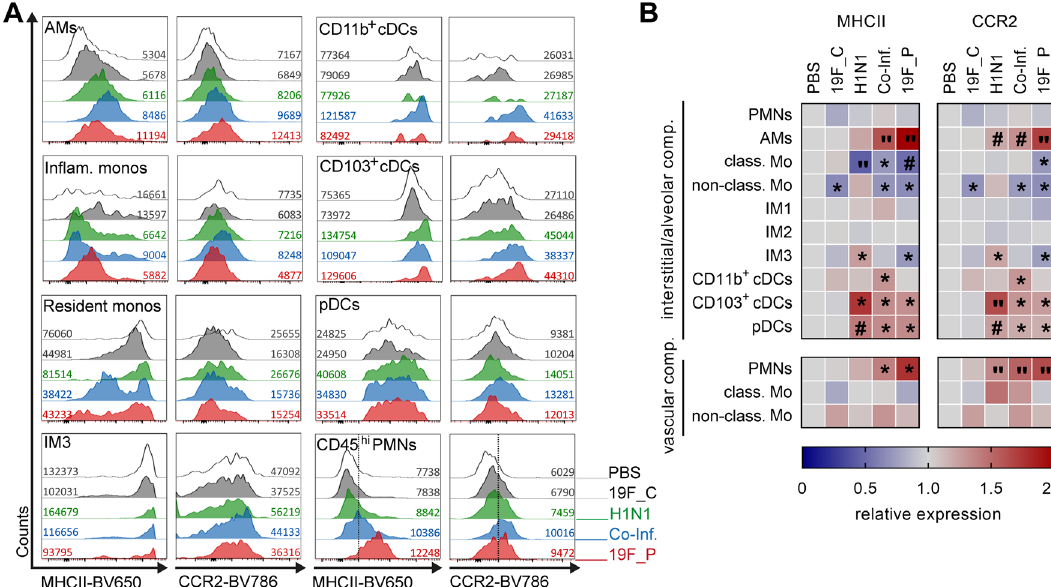
Figure 7. Innate immune cells display enhanced activation at early stages of pulmonary infections. ( A ) Representative histograms of flow cytometry analyses with numbers indicating mean fluorescence intensity (MFI) and ( B ) heat map analyses of relative MFI expression of indicated cell subsets in comparison to the PBS control (n ≥ 8). The level of significance between the PBS and all other groups was determined using Kruskal Wallis test with Dunn’s multiple comparison post-test (* p < 0.05; " p < 0.01; # p <